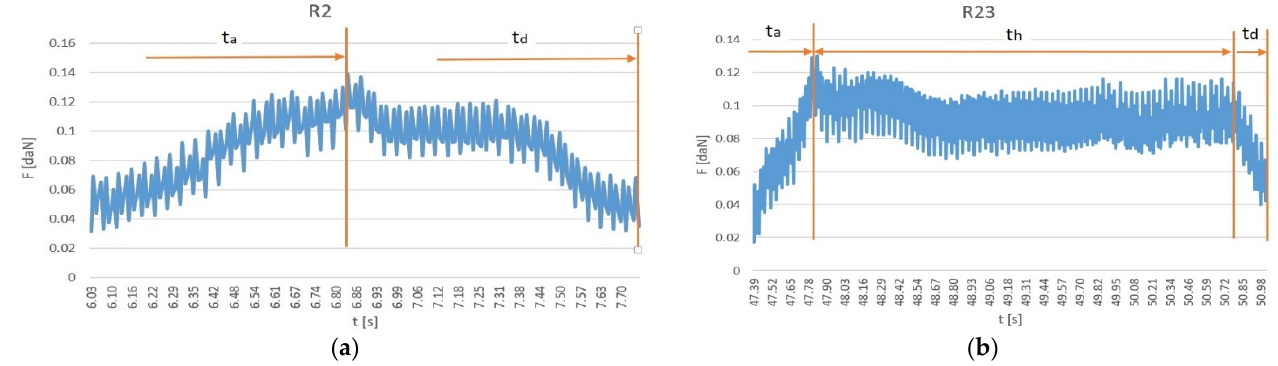
8 of 17 Figure 4. Evolution of maximum forces per cycle—10 kg load. It can be observed that, in the first half of the set, there was a good regularity of fre ‐ quency and amplitude; after that, the maximum force had a decrease followed by a return near the end of the set, in which the subjects tried to add an additional repetition by forc ‐ ing the speed of execution. 3.1.1. Evaluation of the Cycle of One Repetition—Initial and Final For an initial repetition, the evolution of the force for a cycle of one repetition is pre ‐ sented in Figure 5a. The second repetition (R2) was analyzed, being more relevant than